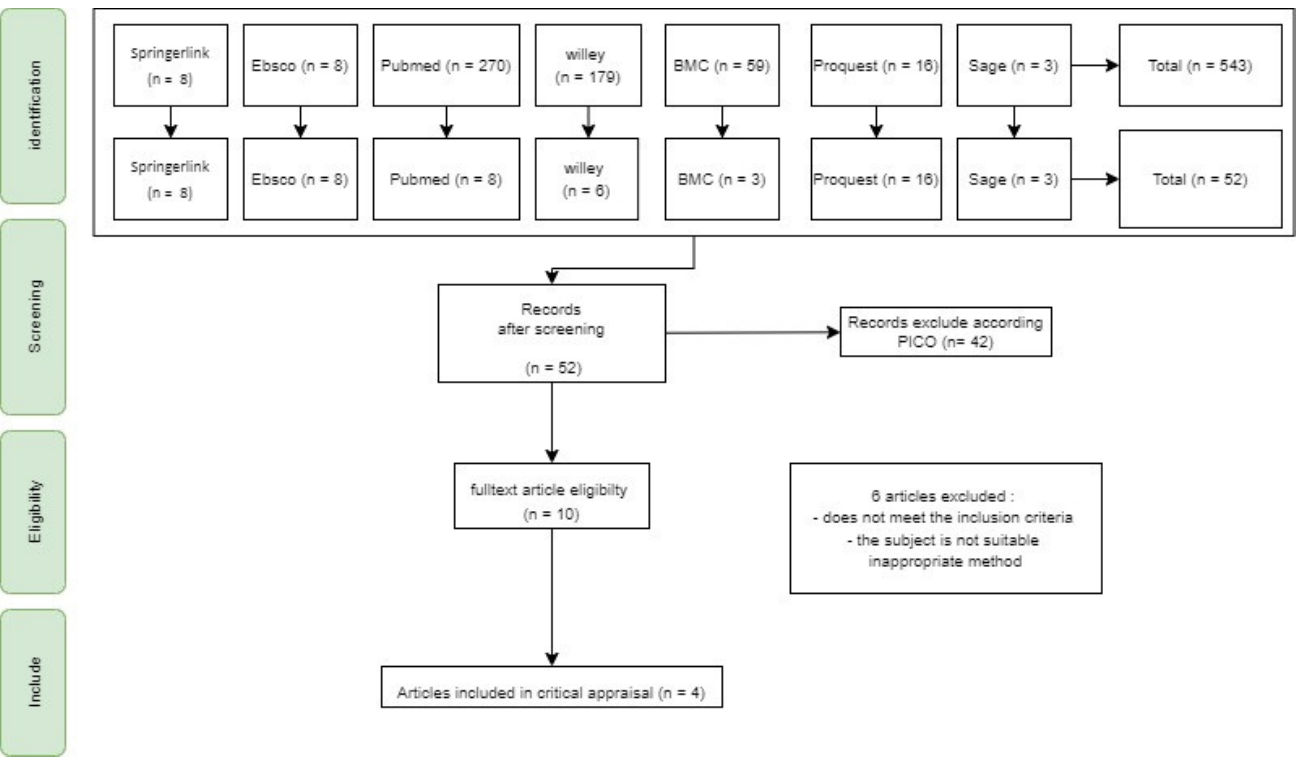
Figure 1. Prism Flowchart. Figure 1. Prisma